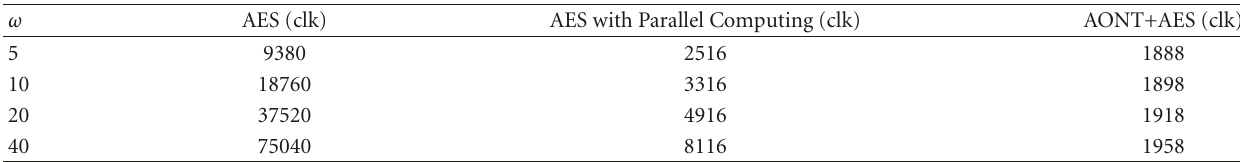
Table 1: The time consumptions of di ff erent encryption